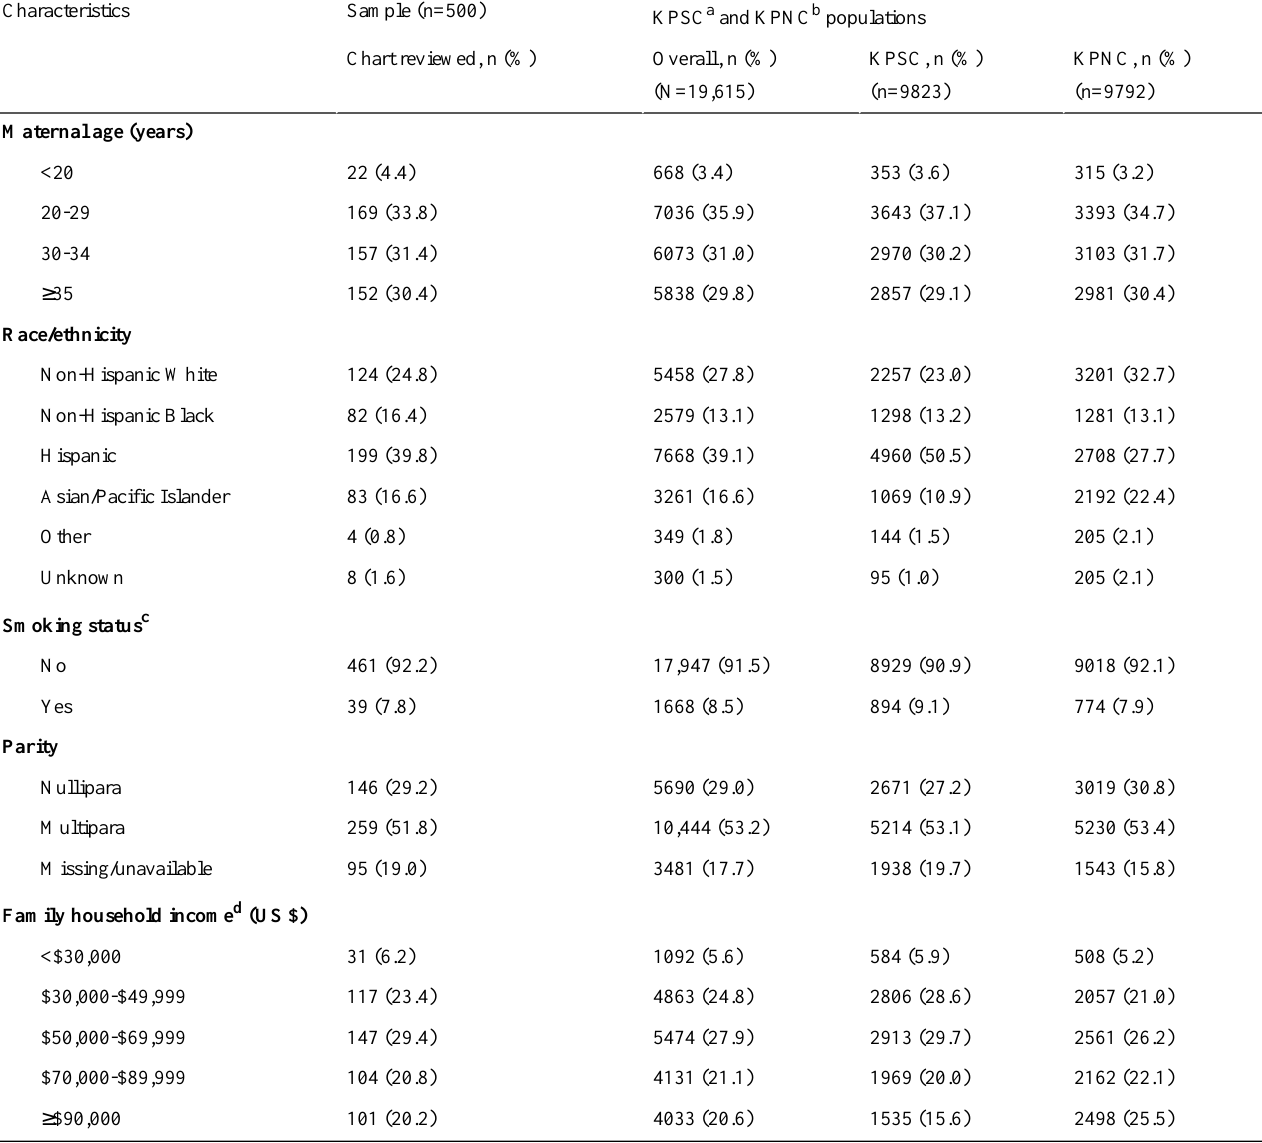
Table 1. Characteristics of the validation study sample and the combined and site-specific populations.